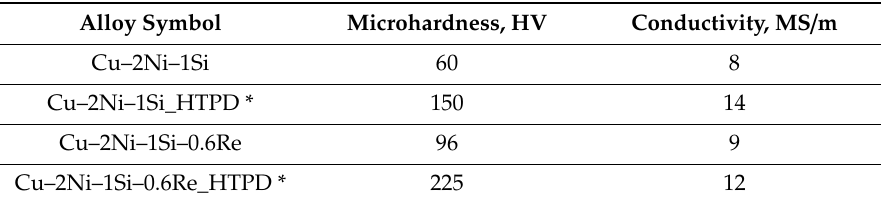
Table 6. Results of tests of microhardness (HV) and electrical conductivity ( γ ) of Cu–2Ni–1Si alloys in cast state and after heat and plastic treatment and of Cu–2Ni–1Si–0.6Re alloy in cast state and after heat and plastic